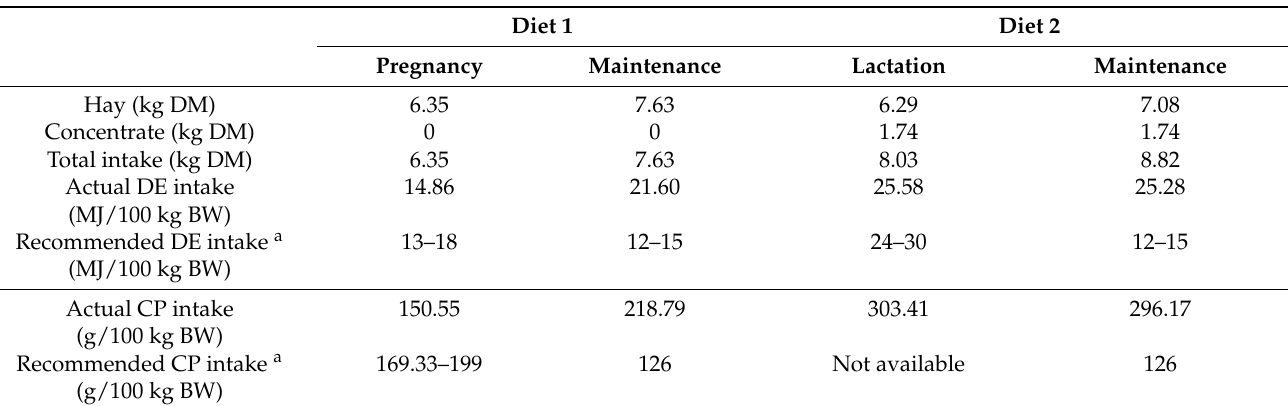
Table 2. Average daily intake for group: Diet 1 and Diet 2. Diet 1